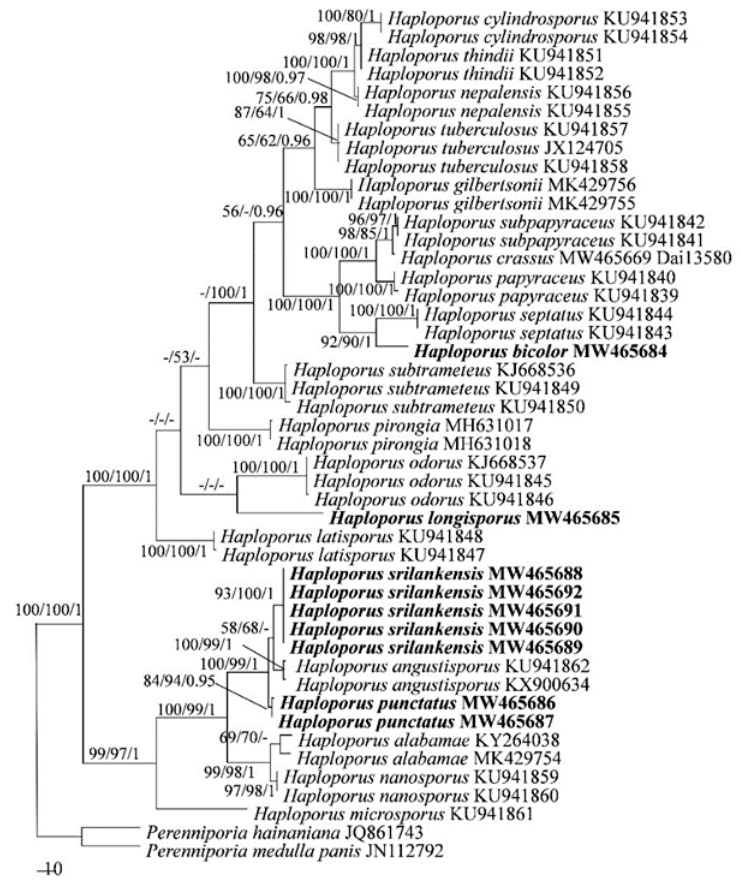
Figure 1. Maximum parsimony strict consensus tree illustrating the phylogeny of Haploporus based on internal transcribed spacer (ITS) sequences. Branches are labeled with parsimony bootstrap values ≥ 50% and Bayesian posterior probabilities ≥